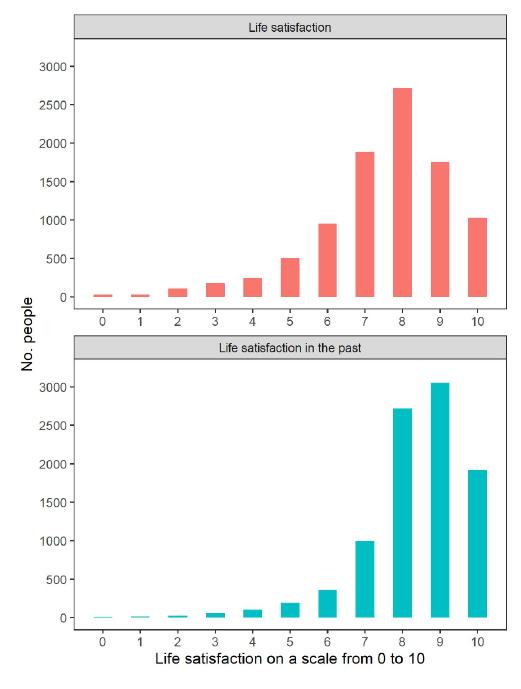
Figure 1: Histogram of life satisfaction in the study population